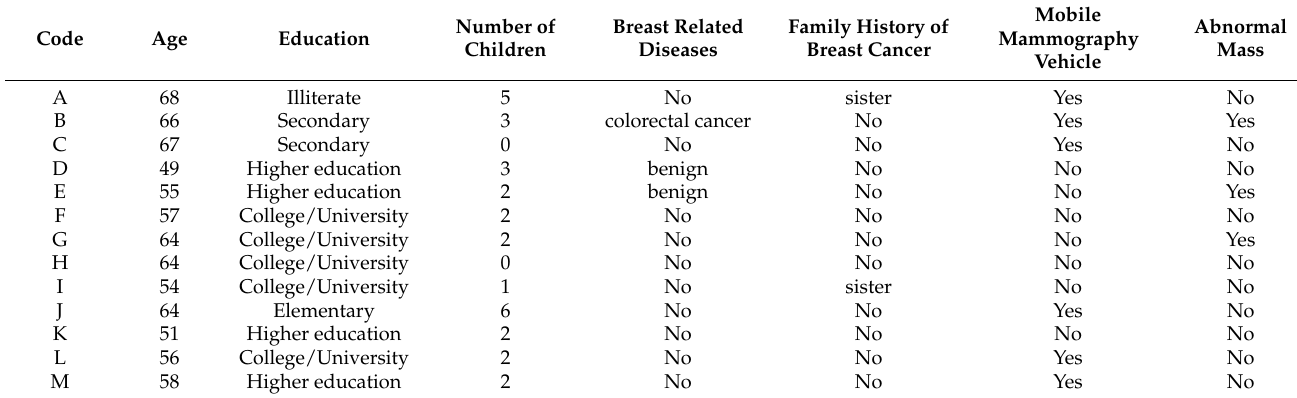
Table 1. Characteristics of the participants ( N = 13).